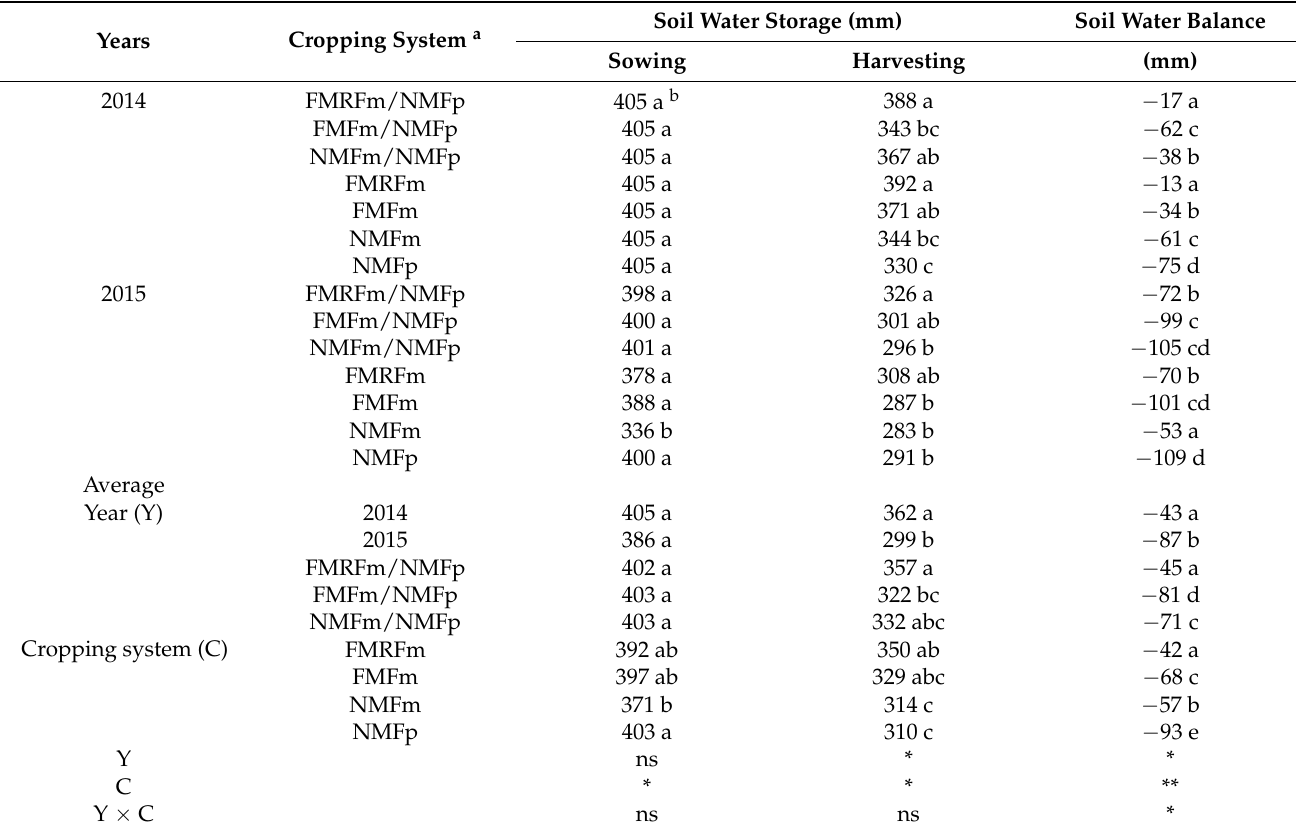
Table 4. Soil water storage in the 0–2 m depth at sowing and harvesting and soil water balance during the growing season under different planting systems in 2014–2015.